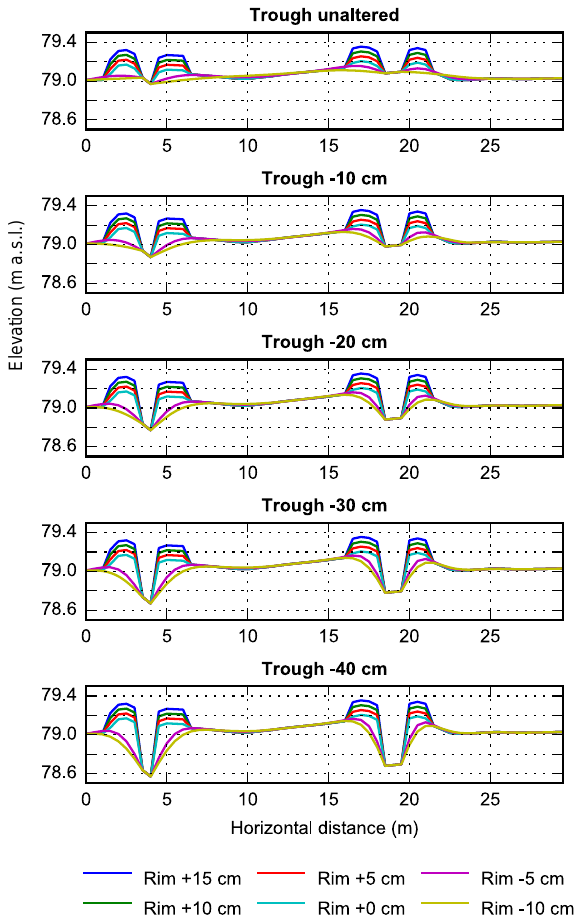
Figure 4. Schematic illustrating the range of topographic conditions explored in the sensitivity analysis (vertical exaggeration =